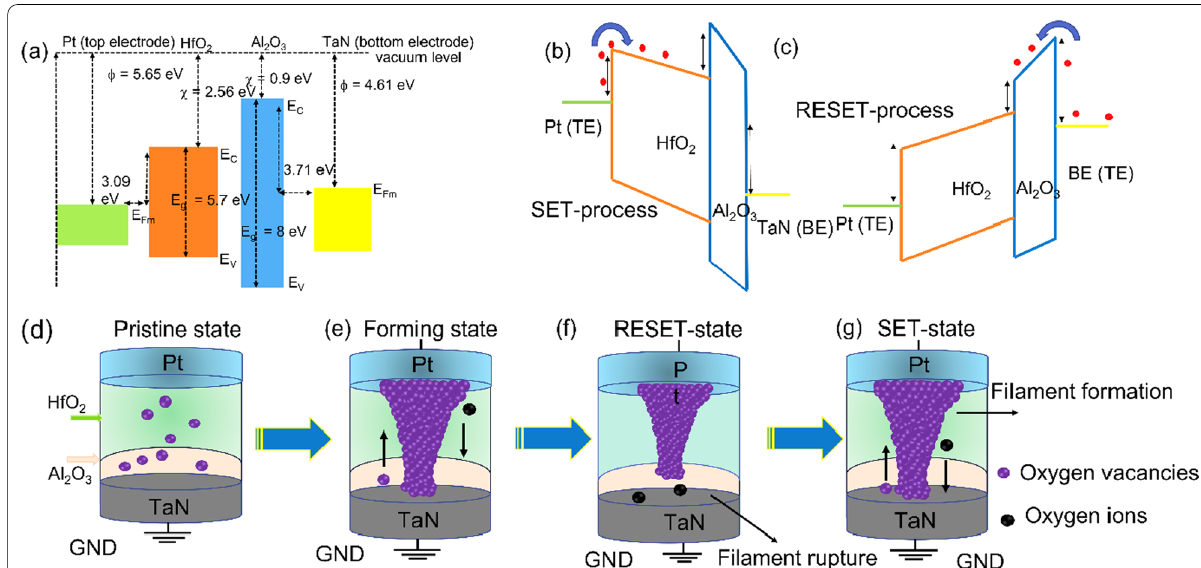
Fig. 8 Relative energy band diagrams and conduction model: a before applying electric field (zero bias), b ON state (forward bias), and c OFF state (reverse bias) of Pt/HfO 2 /Al 2 O 3 /TaN memristive device. Physical model of resistive switching behaviors: d pristine state, e set process (conductive filaments creation under negative bias), and f reset process (filament ruptured under positive bias) of the Pt/HfO 2 /Al 2 O 3 /TaN memristive